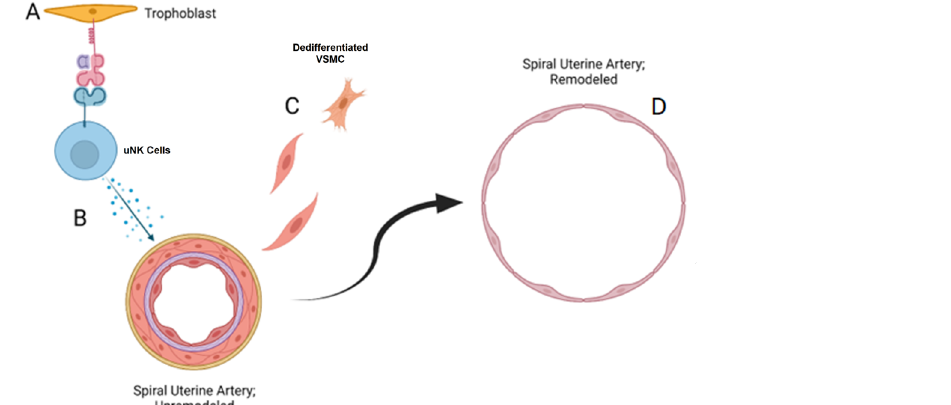
Figure 2. uNK cells induce spiral uterine artery remodeling through secretion of proangiogenic cytokines. (A) NK cells in decidua communicate with EVT cells through HLA-G-KIR2DL4 interactions; (B) dNK cells secrete various proangiogenic factors that increase vascular permeability and induce dedifferentiation of VSMCs; (C, D) SUAs have lost the vascular smooth muscle coat and are dilated in early